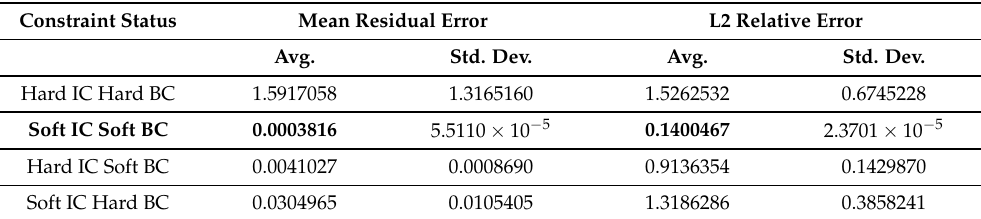
Table 2. Error evaluation of using the best-tested hyperparameters for soft IC and BC constraints (soft–soft) model.